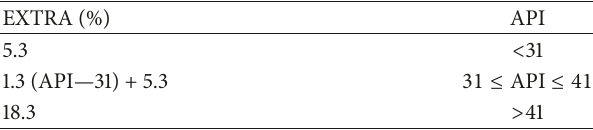
Table 1: The value of EXTRA with different API gravity.